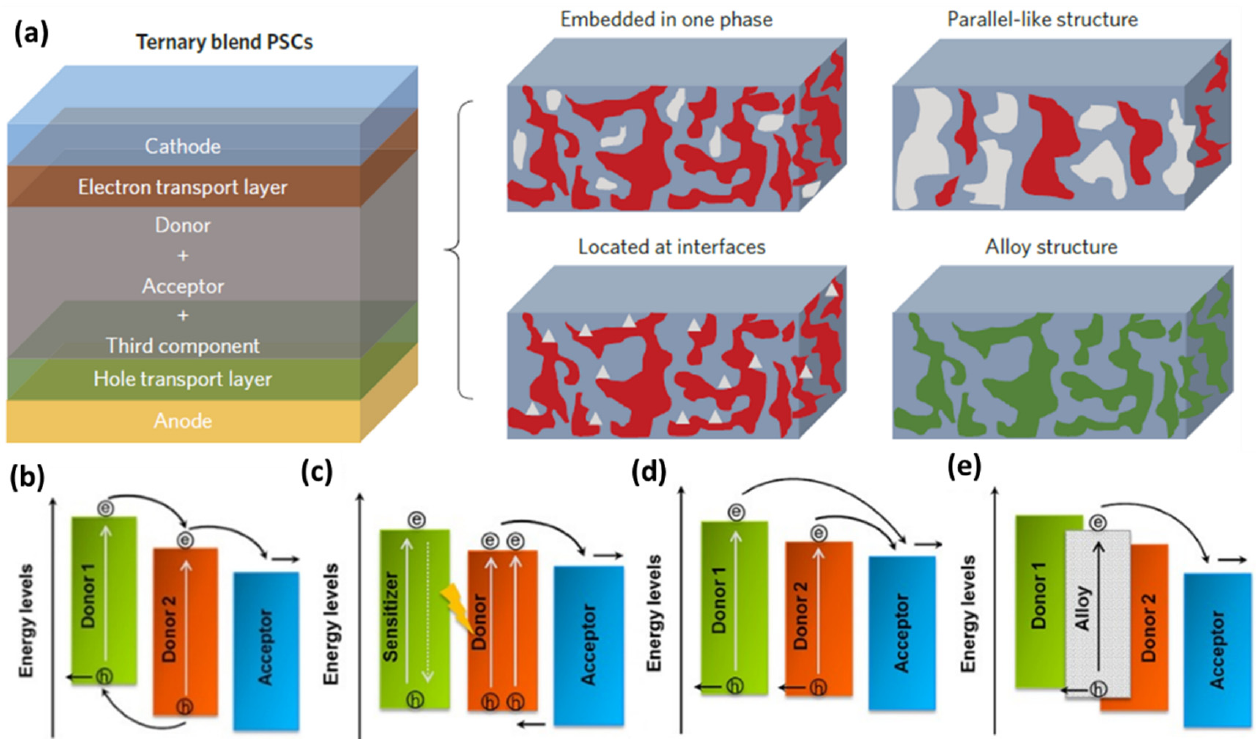
Figure 7. ( a ) Structures of ternary OPVs with four distribution patterns of the third component. Reproduced from [84]. Working principle diagram of ternary OPV based on double donors: ( b ) charge transfer, ( c ) energy transfer, ( d ) parallel-like mechanism and ( e ) alloy model. Reproduced from [90]. Reprinted with permission from ref. [84]. Copyright 2015 Nature Photonics; Reprinted with permission from ref. [90]. Copyright 2017 Wiley.